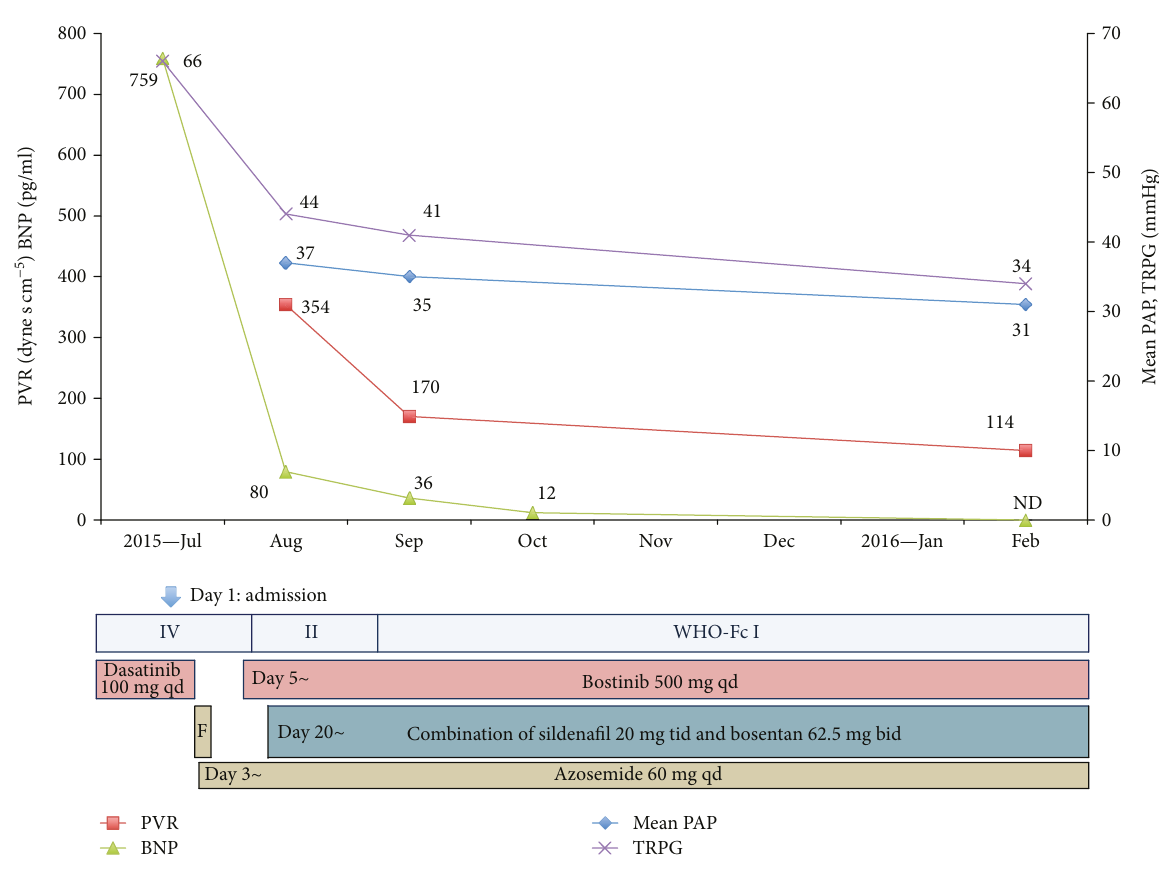
Figure 2: Clinical course of the case. BNP: B-type natriuretic peptide; PAP: pulmonary artery pressure; PVR: pulmonary vascular resistance; TRPG: tricuspid regurgitation peak gradient; WHO-Fc: World Health Organization functional class; F: furosemide 20 mg/day i.v. for three days; ND: not